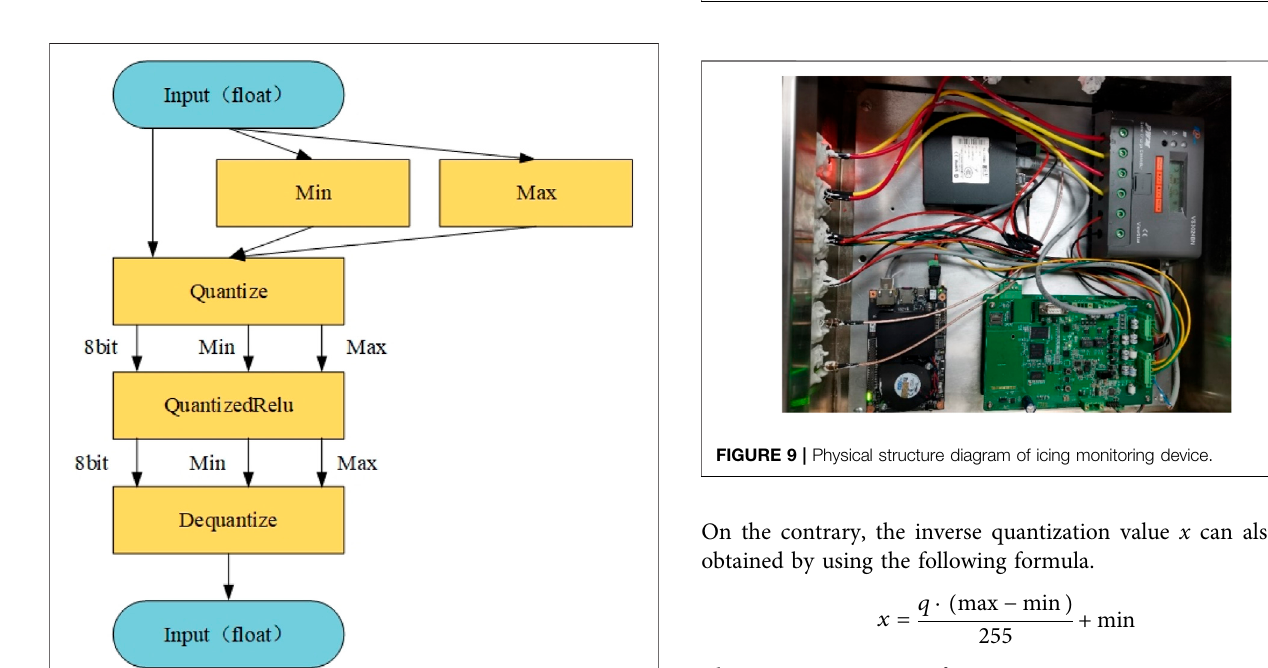
FIGURE 8 | Structure of the icing monitoring device.